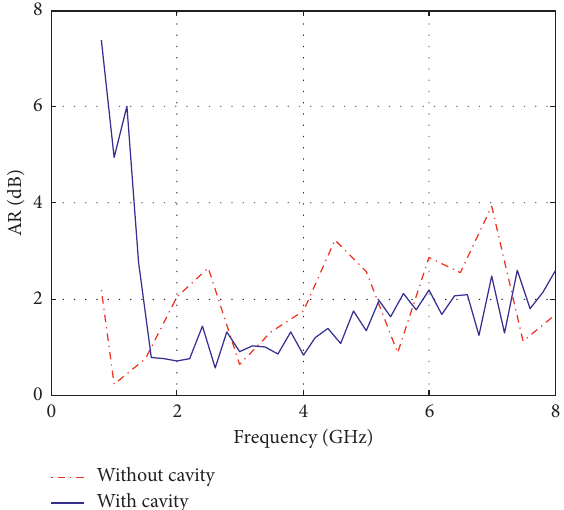
Figure 17: Simulated ARs of the SAAS antennas with and without a cavity.